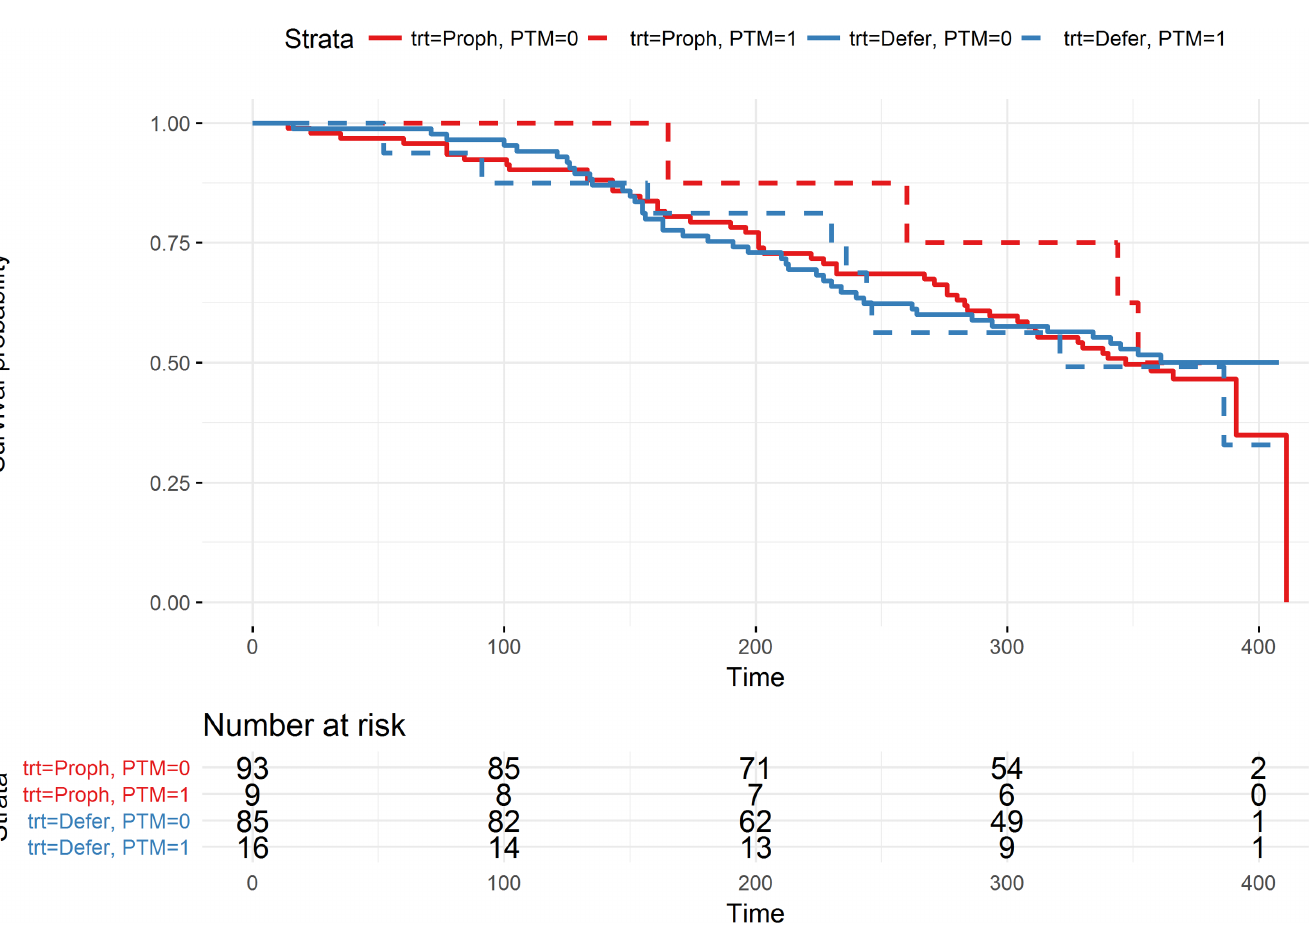
Fig 2. Kaplan Meier curves for treatment and PTM event. The survival rates for prophylactic treatment patients are presented in red, deferred treatment in blue. Patients that experienced a PTM are drawn with dashed lines, no-PTM patients with solid lines. At the bottom of the figure the number of patients at risk at each 100-day interval are noted. Some patients go beyond 365 days (study duration) due to the delay in scheduling their final appointment.